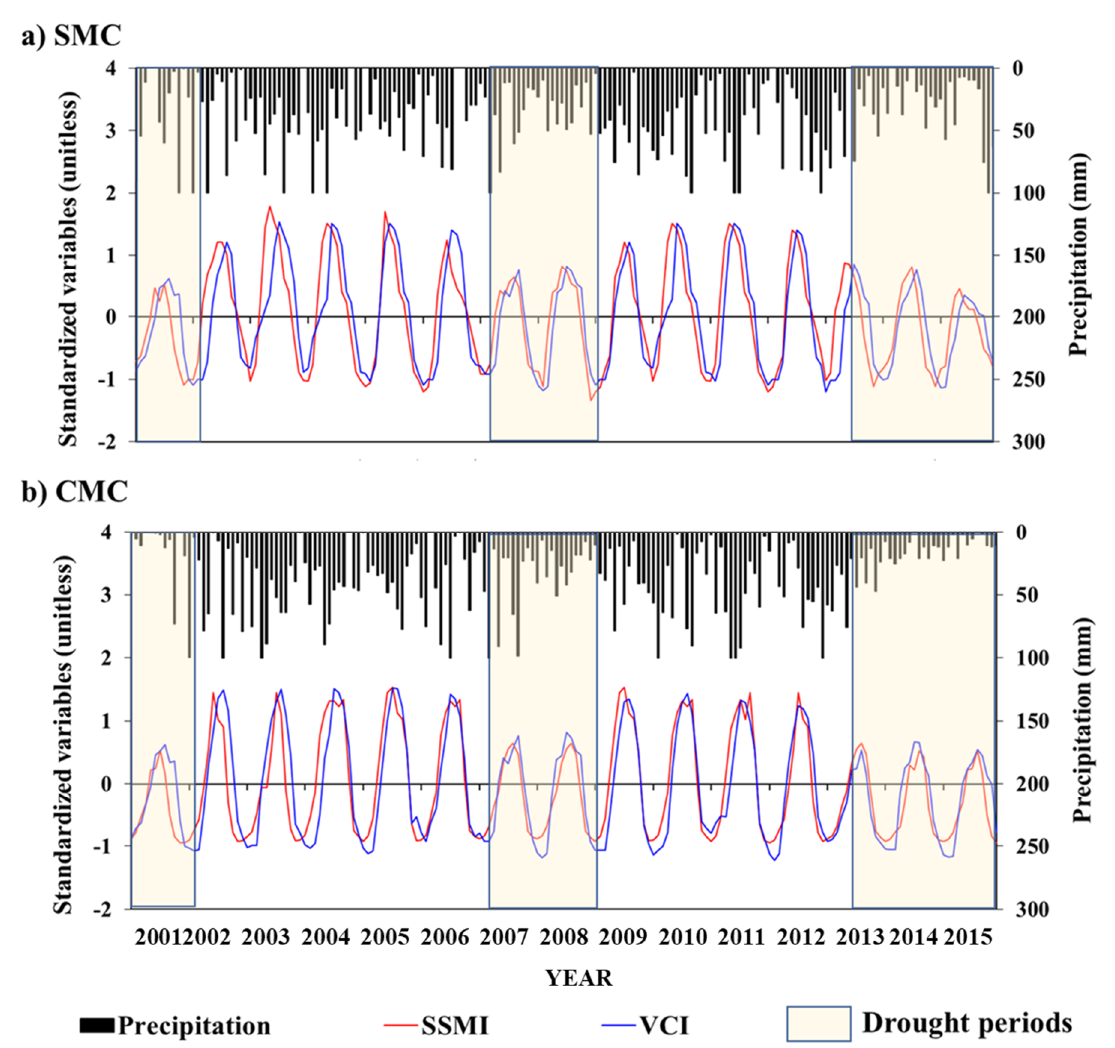
Figure 6. Temporal variations of drought indices and precipitation from 2001 to 2015 at ( a ) SMC and ( b ) CMC site.